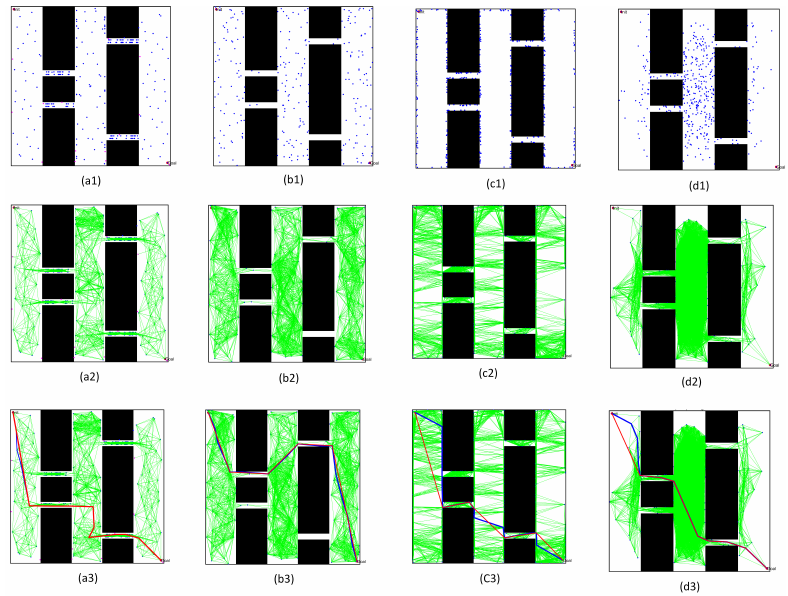
Figure 26. Results of various PRM algorithms in the environment with four narrow channels: ( a1 – a3 ) Based on the sampling method proposed in this paper; ( b1 – b3 ) based on random sampling method; ( c1 – c3 ) based on Gaussian sampling method; and ( d1 – d3 ) based on Bridge sampling